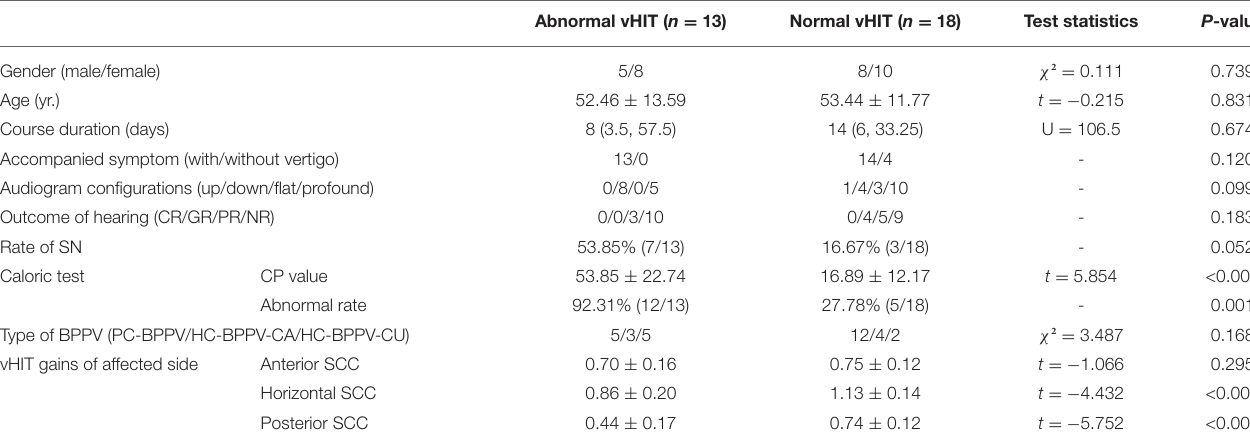
TABLE 3 | Demographic and clinical characteristics of patients with s-BPPV with abnormal vHIT results and those with normal vHIT